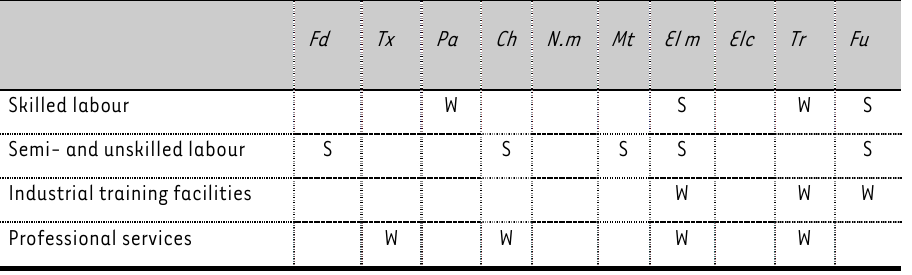
TABLE 4: Effect of Location on Competitiveness: Human Capital Fd Tx Skilled labour W S Semi- and unskilled labour S S S S Industrial training facilities W Professional